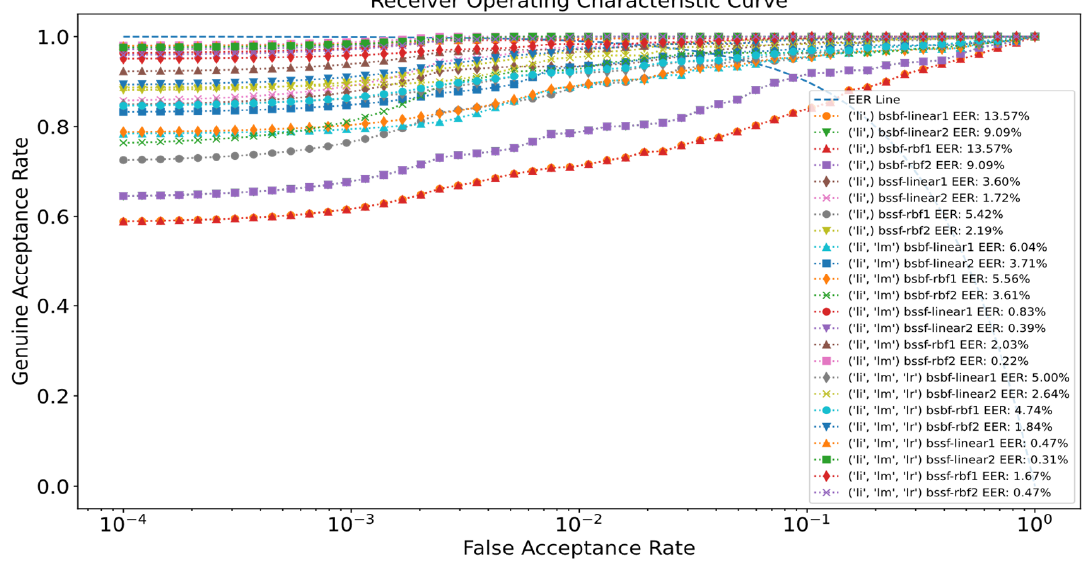
Figure 8. ROC curve of the proposed system for UTFVP.